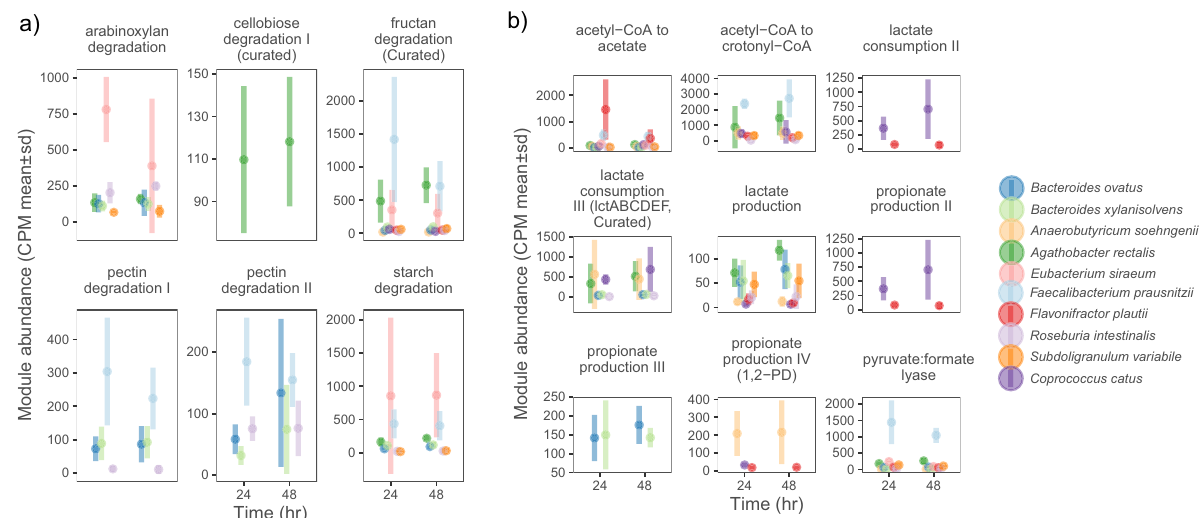
Fig. 6 Comparison of gut metabolic modules (GMMs). a GMMs for poly-, oligo and di- saccharide degradation; b GMMs for short chain fatty acid production. Conversion of acetyl-CoA to crotonyl CoA is considered as proxy for butyrate production due to the dif fi culty in annotation of butyryl-CoA dehydrogenase using KEGG orthologues. Note that different scales were used for the y-axis values in each panel to account for different expression levels of each of the modules. The points represent the mean counts per million (CPM) values and bars represent standard deviation values for each of the